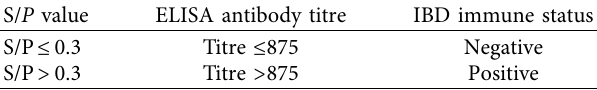
Table 1: Interpretation of IBD immune status based on S/P value and ELISA antibody